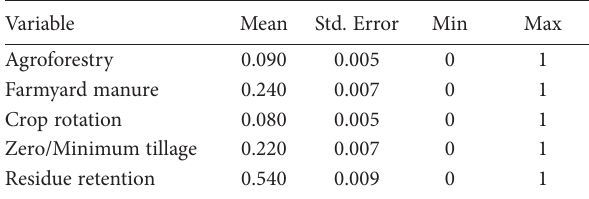
Table 2. Adoption rates of climate-smart practices.